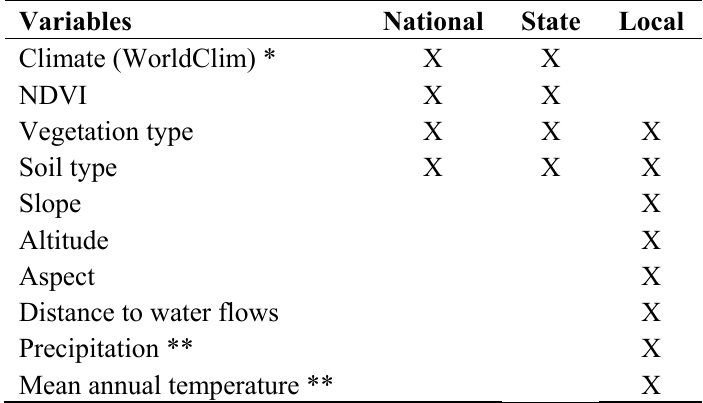
Table 1. Input variables for the MaxEnt model for Picea chihuahuana Martínez in Mexico at national, state and local